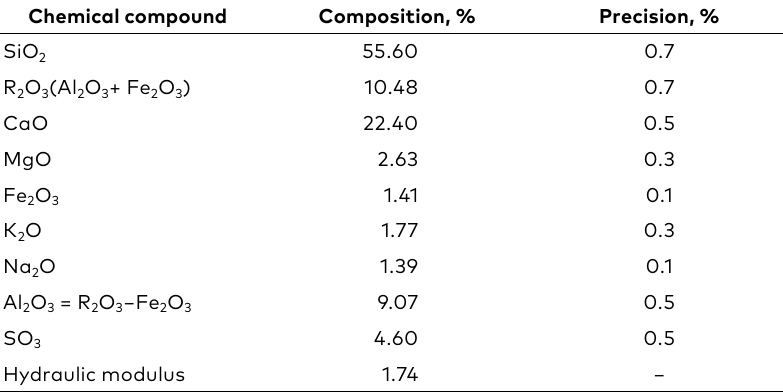
Table 1. Chemical composition of biofuel fly ash